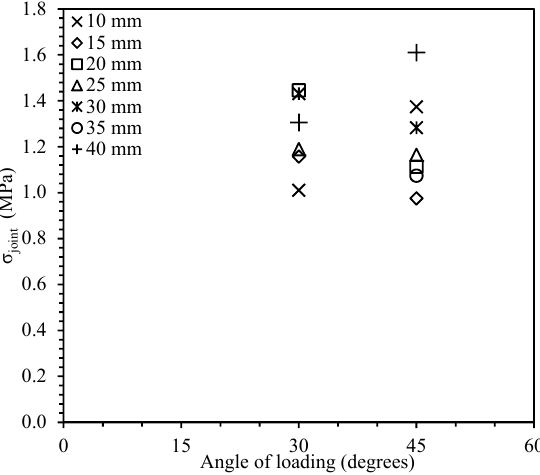
Fig. 7 Joint strength against loading angle at 1m/s.